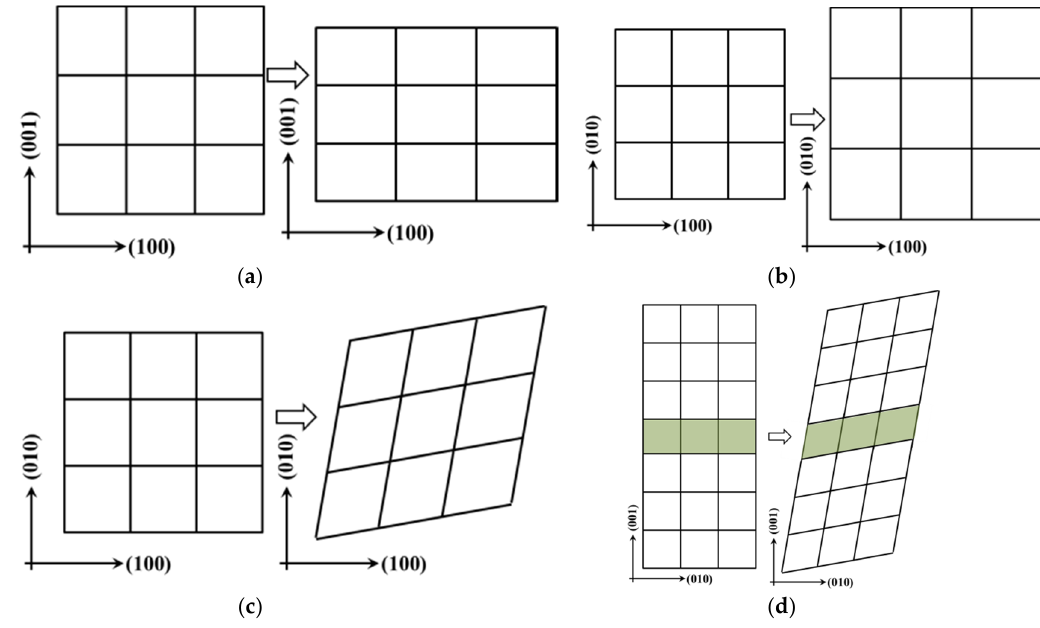
Figure 2. Strain configuration of calculation mechanical properties of the interfaces in Ti–Si–N: ( a ) tetragon shear strain; ( b ) expansion or shrinkage strain; ( c ) rhomb strain of parallel to interface; ( d ) rhomb strain of perpendicular to interface.